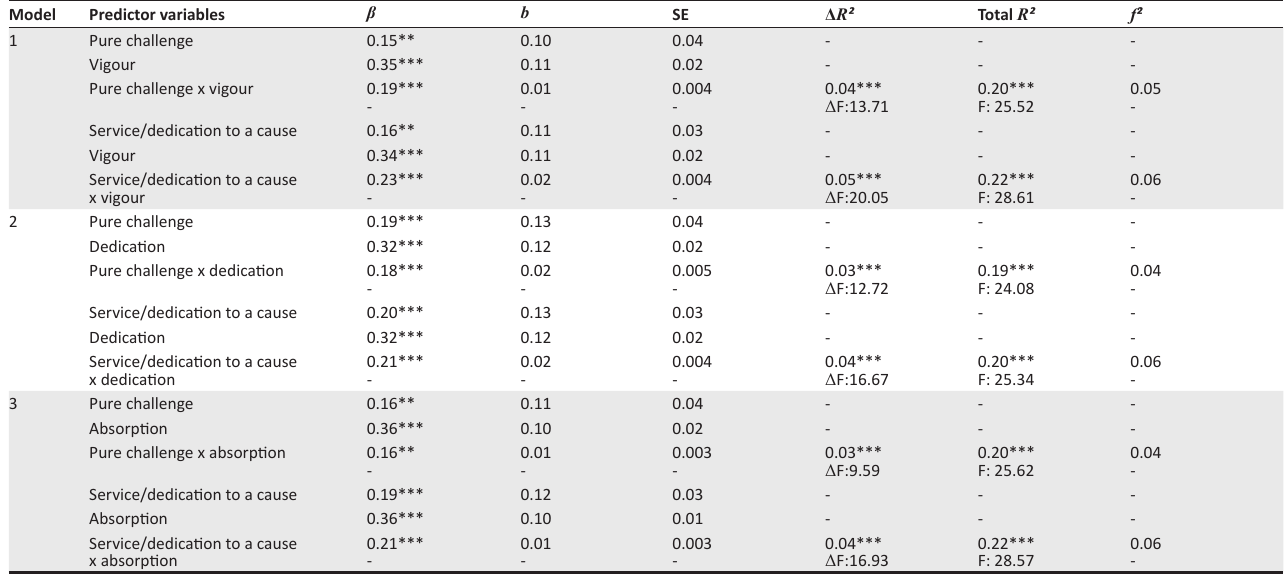
TABLE 5: Moderated regression analysis examining the interaction effects between the pure challenge and service/dedication to a cause career anchors and vigour, dedication and absorption (work engagement) on job commitment.